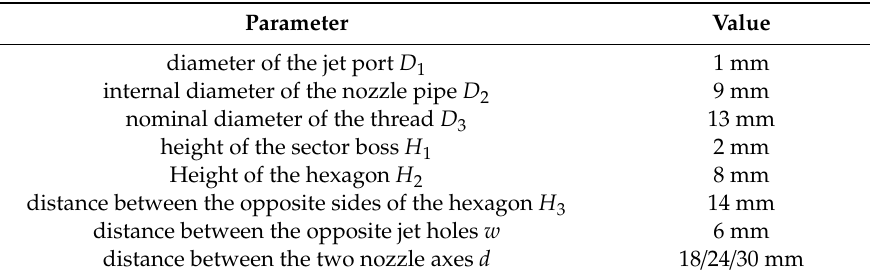
Table 1. Nozzle structure parameters.